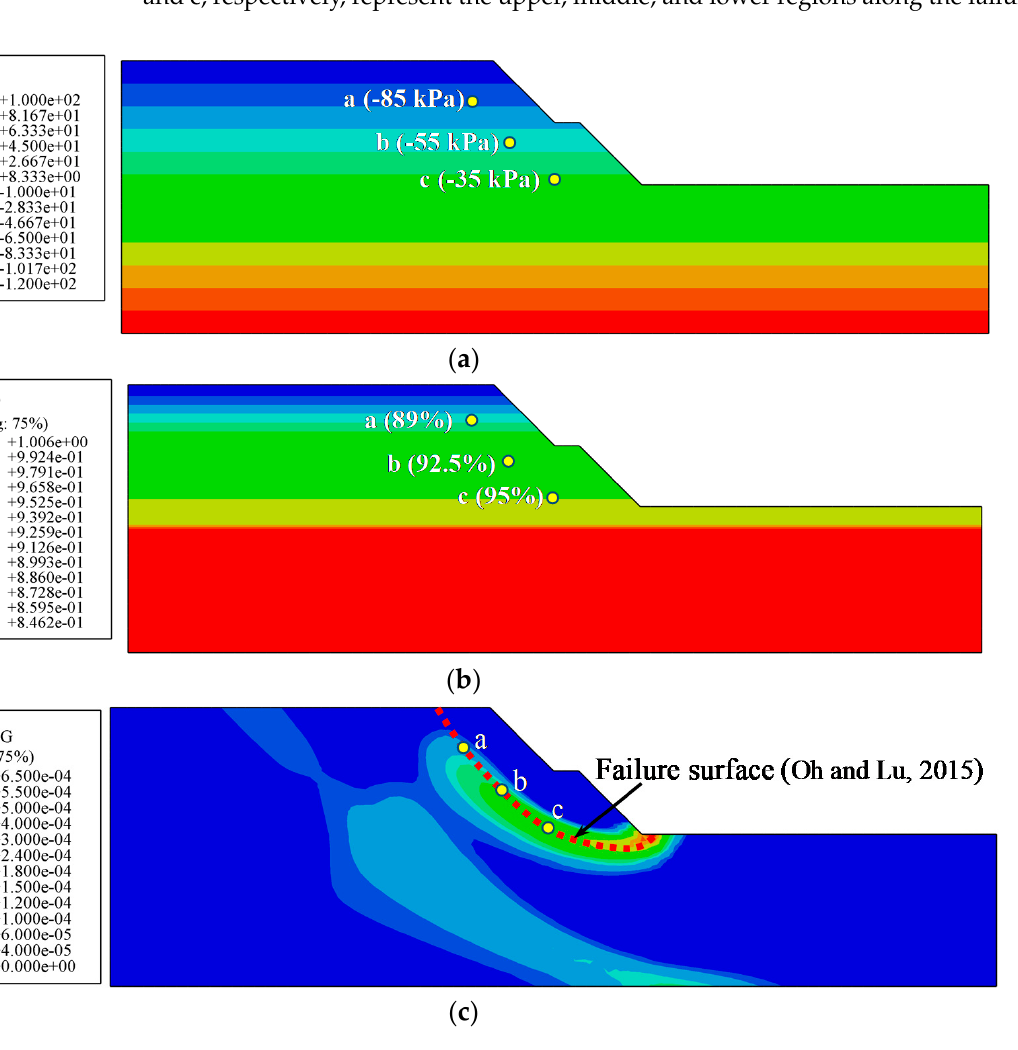
Table 2. Geotechnical and hydromechanical properties of Pohang soil [21].